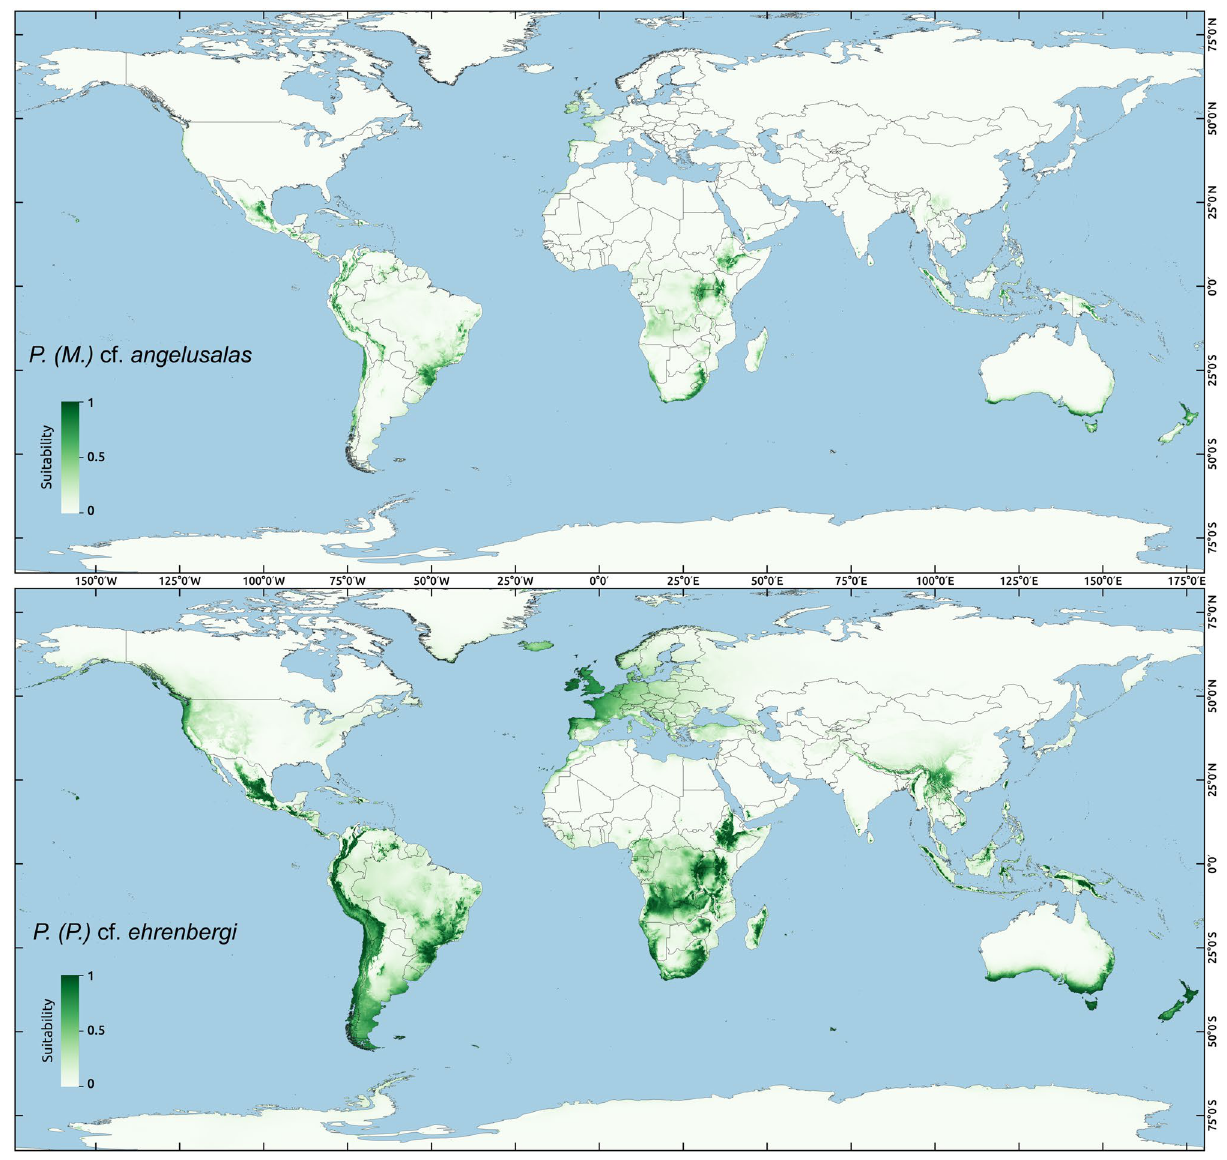
Figure 8. Ecological biogeography of two Pseudechiniscus species with pantropical distributions – geographic ranges predicted by ecological niche modelling for: ( A ) P. (M.) cf. angelusalas , ( B ) P . (P.) cf. ehrenbergi . Suitability determines whether a given area is characterised by favourable conditions for one of the species (maximal suitability = 1) or by allegedly inhospitable conditions (minimal suitability = 0). Generated using Maxent, ver. 3.4.1 103 [https:// biodi versi tyinf ormat ics. amnh. org/ open_ source/ maxent/] with kuenm package 104 Ventral ornamentation pattern only recently was found to be pivotal in the taxonomy of Pseudechiniscus 22–24,41 ,